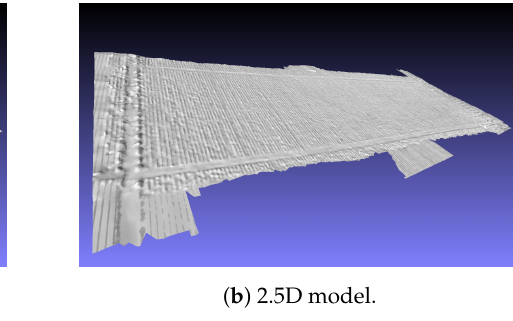
Figure 32. Models generated from thermal images.